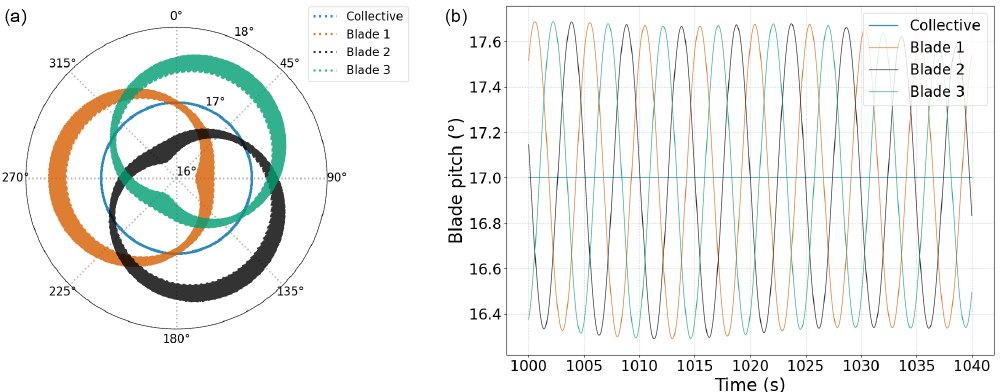
Figure 12. Blade pitch angles (collective blade angle in blue, blade 1 in orange, blade 2 in black and blade 3 in green) for yaw-by-IPC and an NWP wind speed of 20ms − 1 with respect to azimuthal position (a) and time (b) .